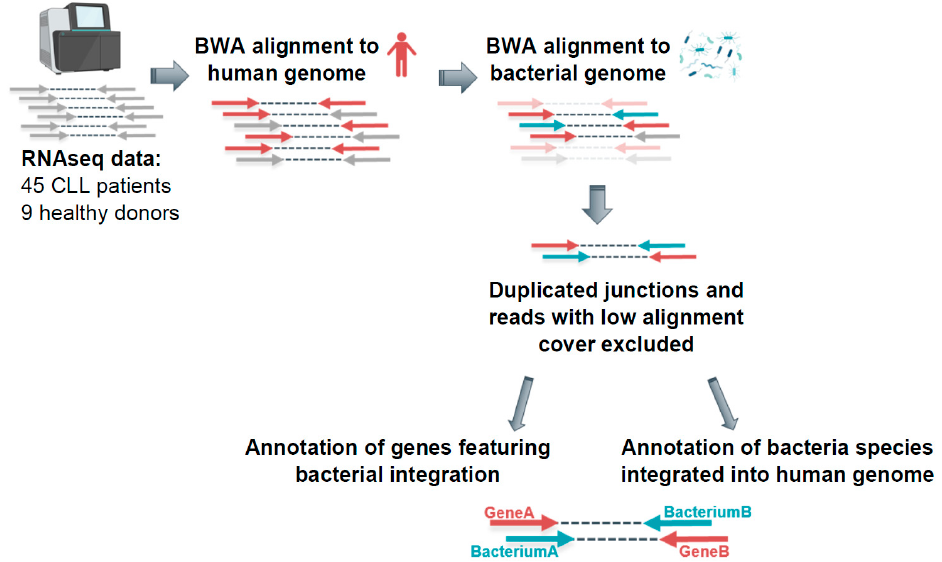
Figure 1. Detecting bacterial integrations into the human genome in CLL patients—analysis workflow. RNAseq data were aligned to the human genome (hg19) and subsequently to bacterial genome references via BWA. The reads supporting LGT were defined as reads featuring only one mate mapping exclusively to human genome and only one mate mapping exclusively to bacterial genome.